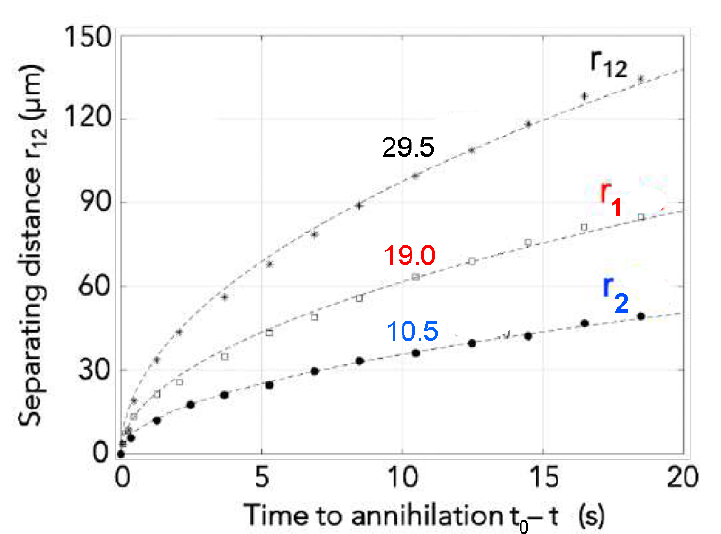
Figure 4. Distances of two matching defects with respect to the annihilation point. The graphs show the defect separation r 12 and the distances r 1 of the + 1 defect and r 2 of the − 1 defect from the point where they finally meet and annihilate. The dashed lines are square-root fits r = d and the numbers give d in units of µ ms − 1/2 . Image adapted from Reference